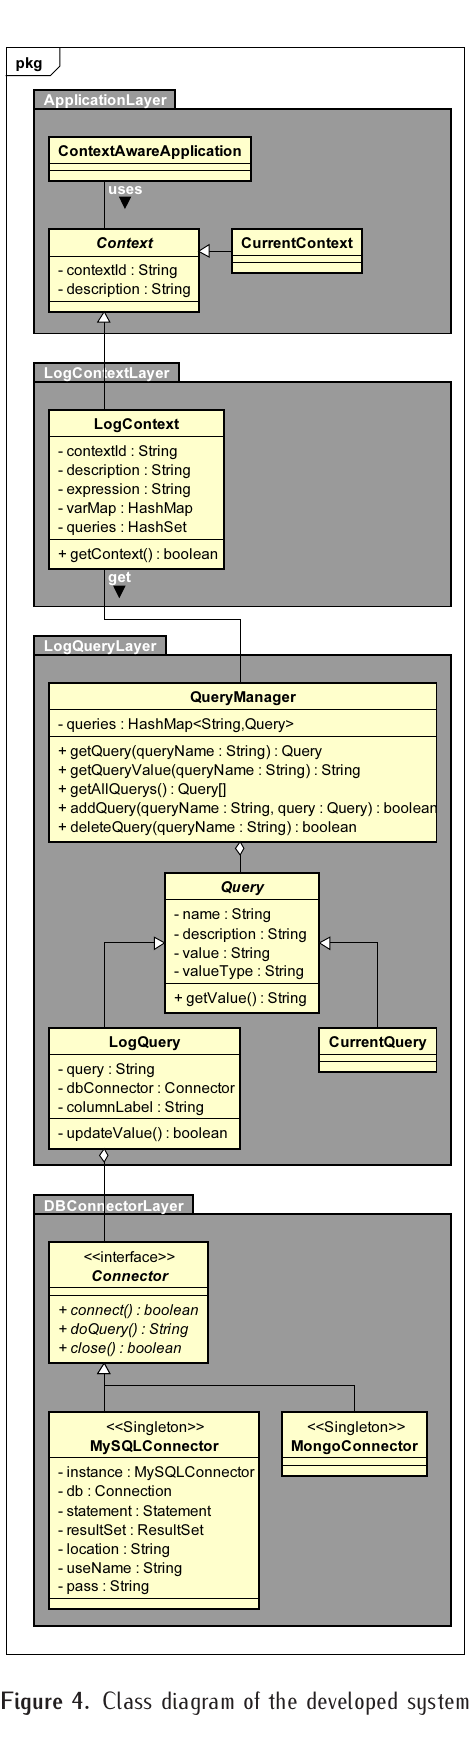
Figure 4. Class diagram of the developed